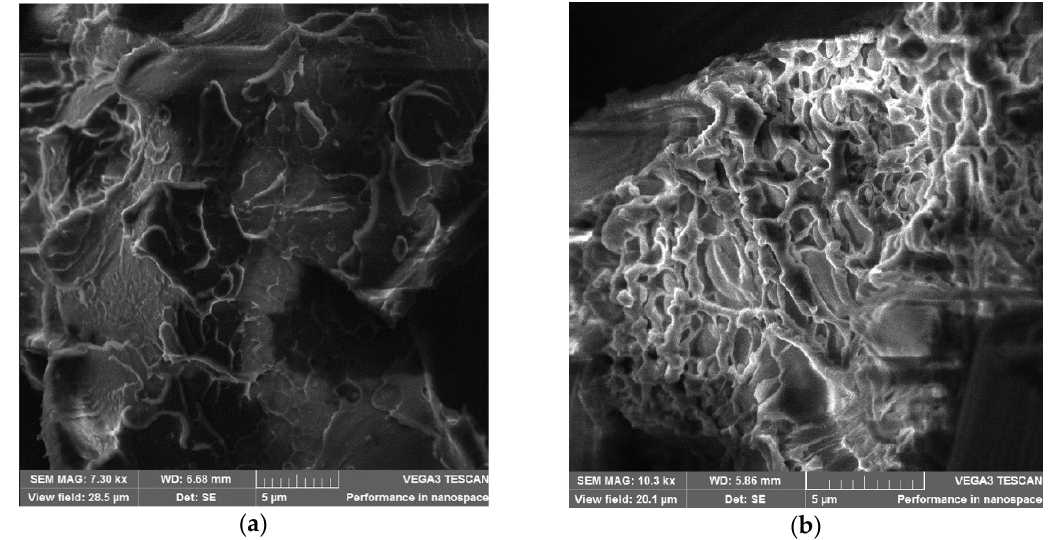
Figure 9. SEM images of the polymer matrix of carbon-filled samples: ( a )—PEI-CF + 15% OPSU; ( b )—PEI-CF + 10% PC. Table 6. Heat resistance of carbon-filled PEI with di ff erent content of OPSU and